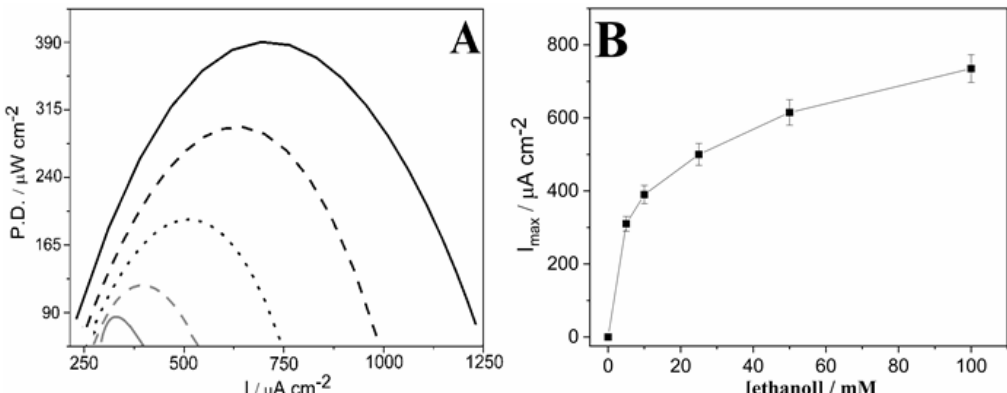
Figure 6. Representative power curves of the enzymatic biofuel cell (EBFC) as a function of ethanol concentration (0–100 mM) ( A ) and a scheme of the 150 mM citric acid-phosphate buffer at pH = 5.2 and 25 °C ( B ): the error bars represent one standard deviation from the mean ( n = 3). Table 1. Power density generated for different ethanol self-powered biosensors (ESPB) ethanol biofuel cell architectures.